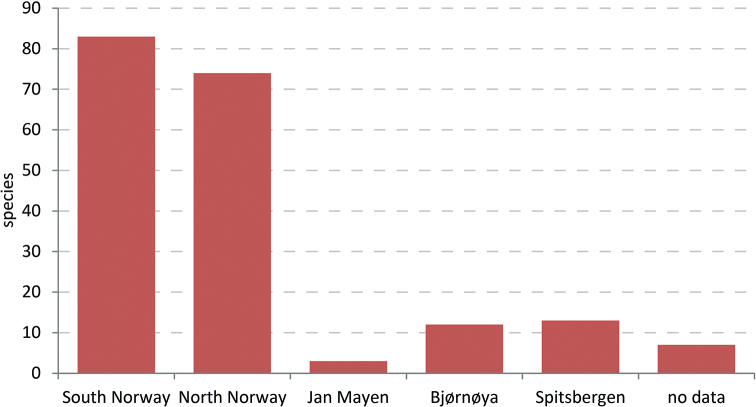
Distribution of sciarid species in Norway based on published records until 31 December 2019. ‘North Norway’ includes the counties Nordland, Troms and Finnmark, while the remaining counties of the Norwegian mainland are grouped as ‘South Norway’.